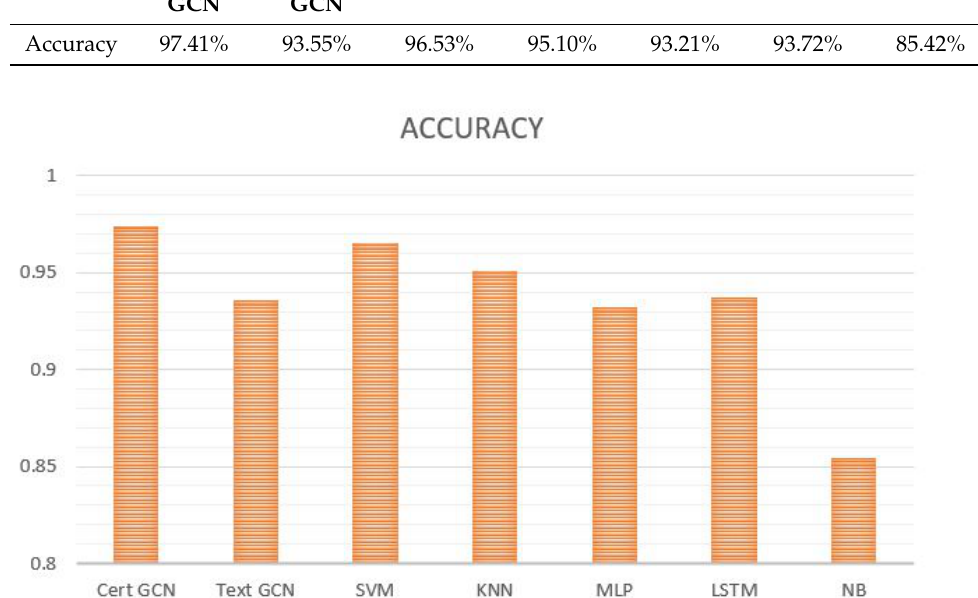
Figure 10. Accuracy of various algorithms in predicting malicious